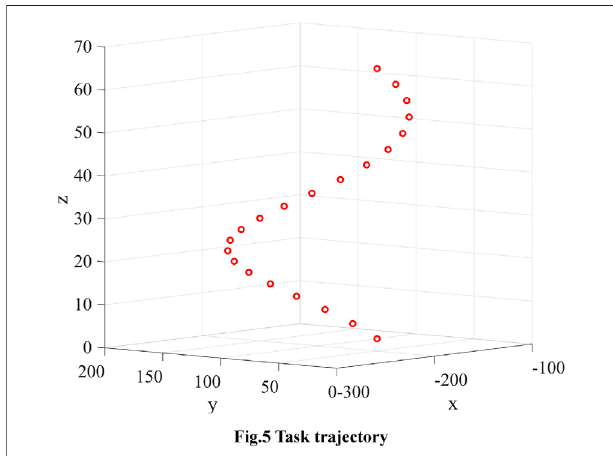
FIGURE 5 | Task trajectory.